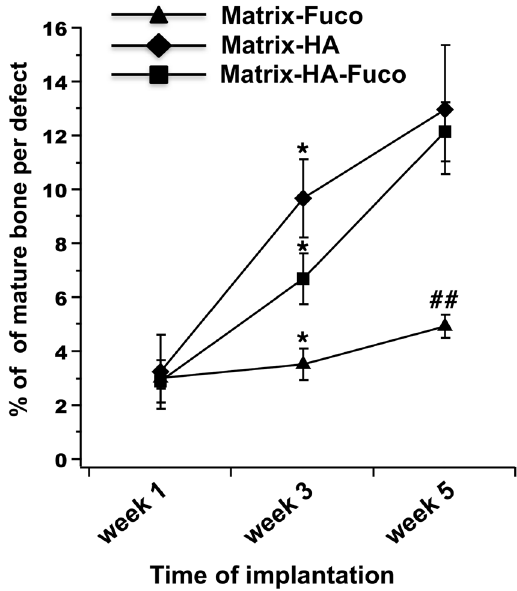
Figure 4. Percentage of bone formation within the implanted matrices over time of implantation. The quantification was performed from Trichrome Masson staining slides (n = 3) on the defects filled with the three groups of biomaterials over weeks 1, 3 and 5. Significant differences between biomaterials at each week are indicated with * p < 0.05 for week 3 and ## p ≤ 0.01 for week 5. Of note, the percentage of bone formation obtained on the Matrix-HA-Fuco filled defects were significantly different to each other at each time point. The percentage obtained on the Matrix-HA filled defects at week 1 was significantly different to the ones obtained at week 3 and week 5. Similarly, the percentage obtained on the Matrix-Fuco filled defects at week 5 was significantly different to the ones obtained at week 1 and week